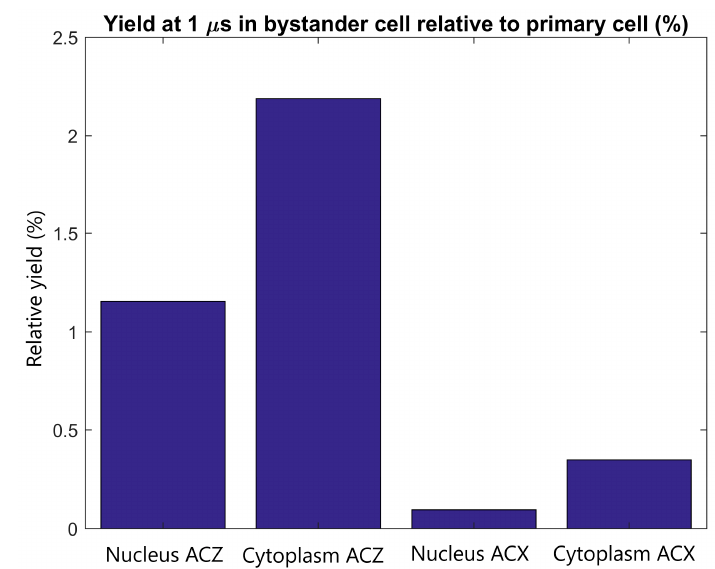
Figure 6. The radiolysis yield at 1 µs in the nucleus and cytoplasm of the adjacent cell relative to the yield for the primary cell from electrons emitted by GNPs within the primary cell. Results are shown for tightly packed cells with separations parallel to the proton beam (along the Z axis) and perpendicular to the proton beam (along the X axis).